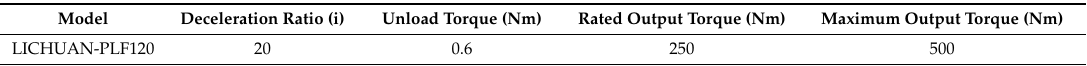
Table 3. The main parameters of the weighing sensor.